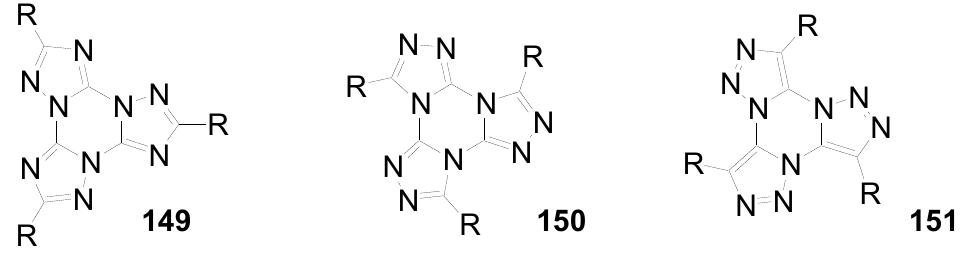
Figure 34. C - symmetrical 3